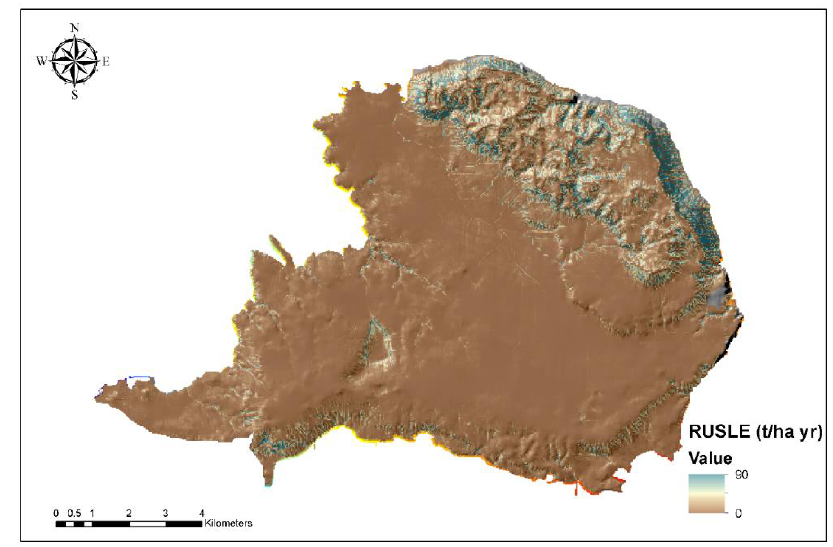
Figure 10 . Soil erosion [Revised Universal Soil Loss Equation (RUSLE)] map of the study area.